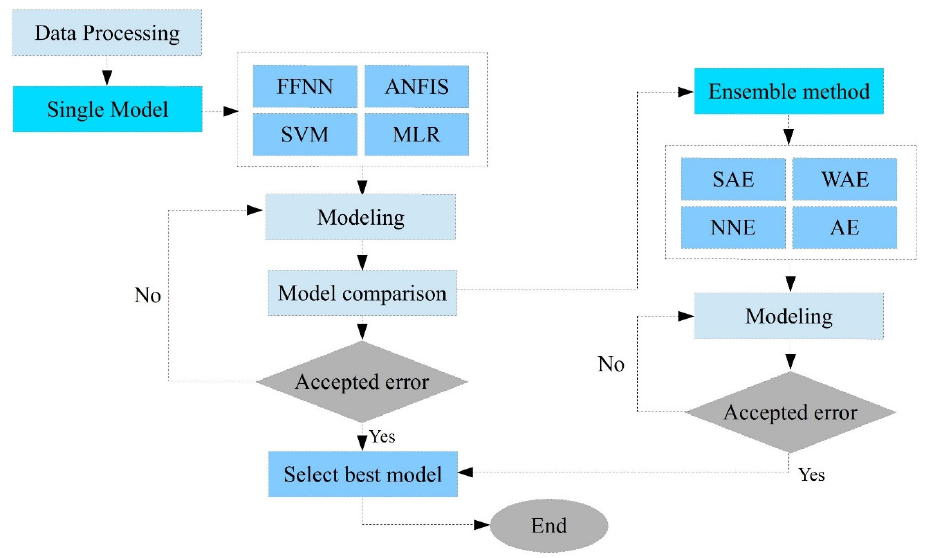
Figure 1. Schematic diagram of the AI-driven models’ development.